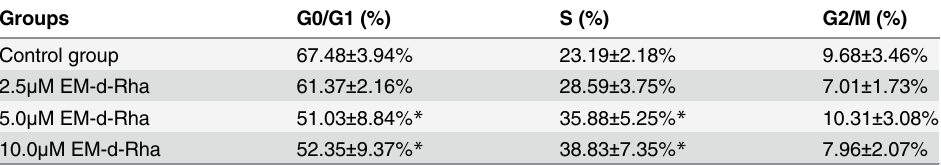
Percentage of cell cycle distribution are means of three independent experiments (n = 3, mean ± S.E.M). * represent p < 0 . 05 vs . control group